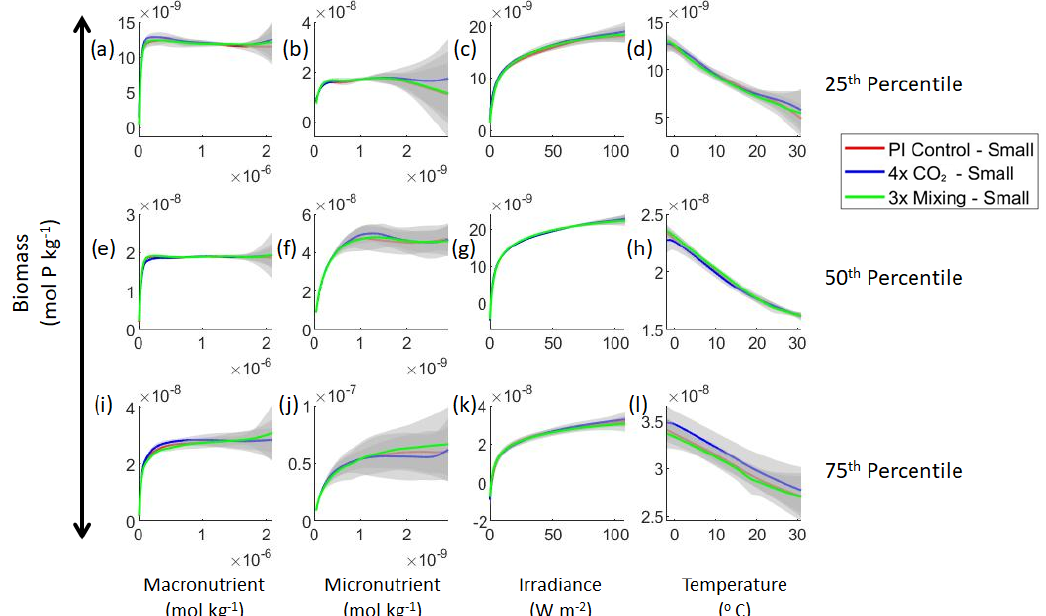
Figure 4. Sensitivity analysis plots for the small phytoplankton of Case 1. This figure is provided to allow for examination of the apparent relationships for the small phytoplankton, since the large phytoplankton apparent relationships made it difficult to see those for the small phytoplankton in Fig. 3. Each line is the prediction for the NNE (i.e., the average prediction of 25 NNs) specific to each model run, and the color of each line represents the model run (PI Control – red; 4 × CO 2 – blue; 3 × Mixing – green). The gray region around each line shows 1 standard deviation in the predictions of the individual NNs that make up each NNE (e.g., the gray region around the solid red curves shows the standard deviation in the predictions of the 25 NNs that make up that particular NNE). The rows correspond to the percentile value at which the other predictor variables were held constant (e.g., panel a varies the macronutrient across its min–max range and holds the micronutrient, irradiance, and temperature at their respective 25th percentile values). Columns show the x -axis variables as they vary between their min–max range. The y axis in all panels is the biomass concentration. Note that the biomass scale changes with each panel.